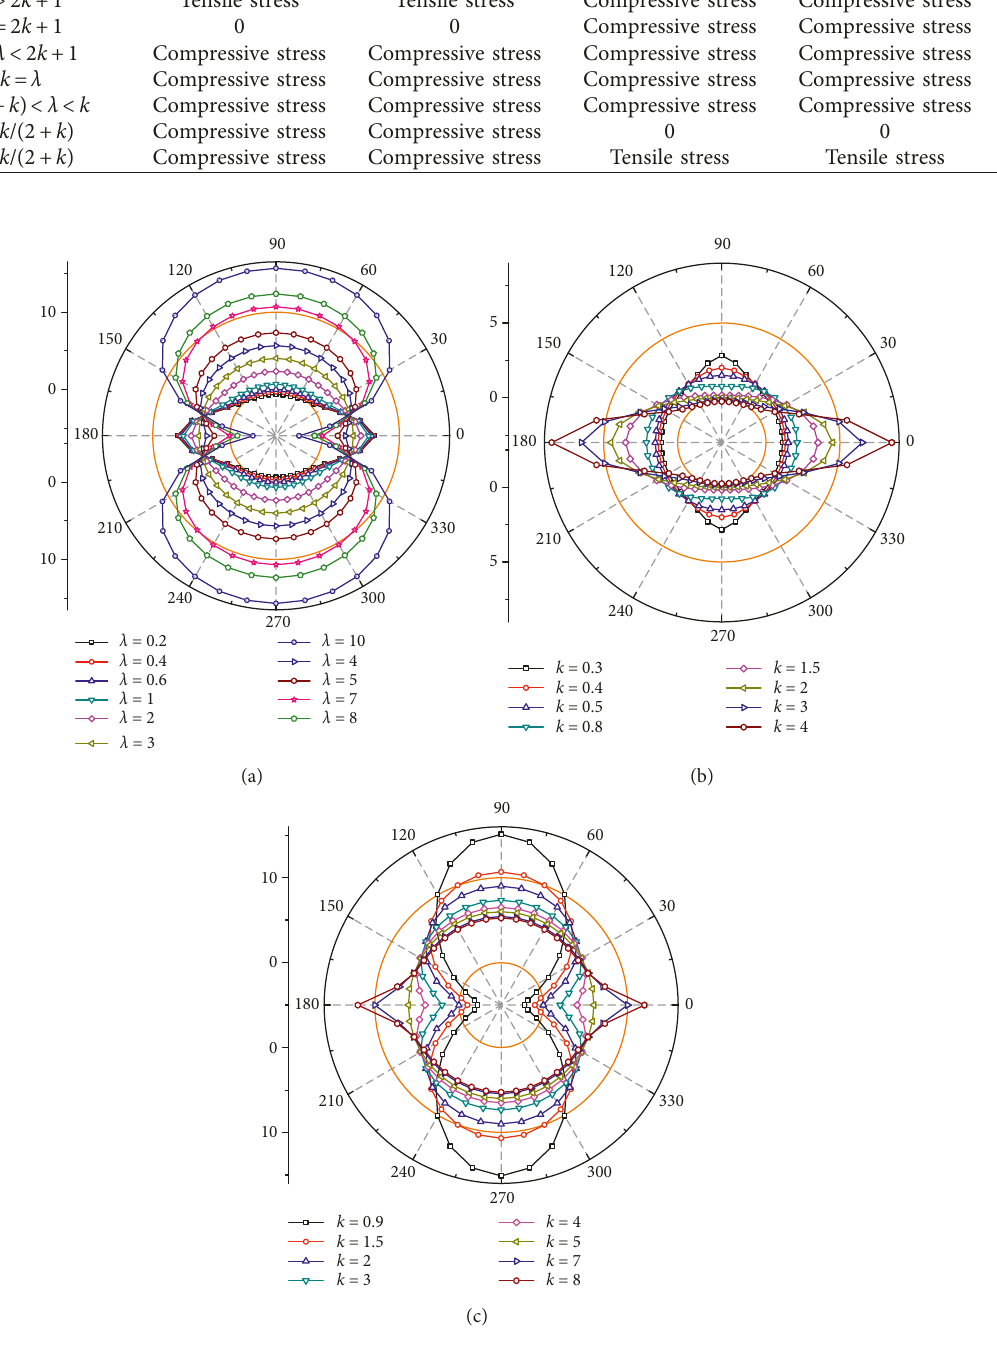
Figure 3: Distribution characteristics of tangential stress concentration factor on stress elliptic boundary under different conditions. (a) k � 3, (b) λ � 0.5, and (c) λ �